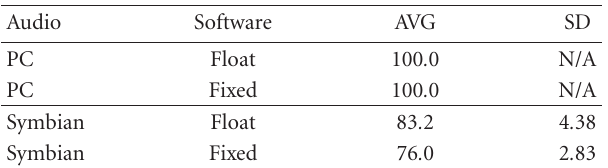
Table 4: Recognition rate average and standard deviation for GSM/PC experiments with 25 speakers, 5 repeated cycles of train- ing, and